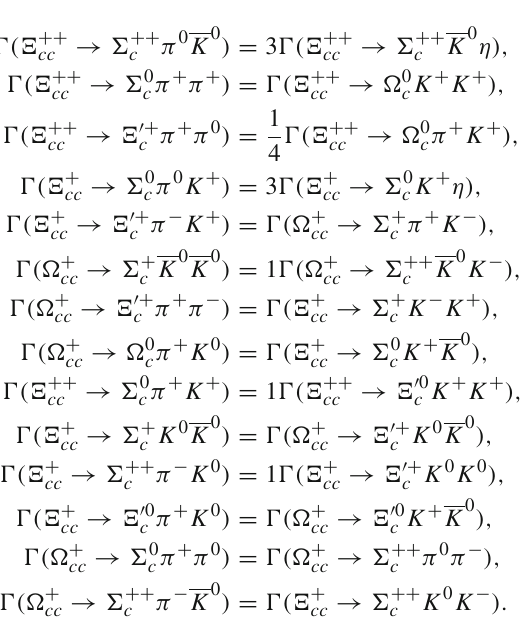
A.3: (cid:2) bb and (cid:5) bb decays into a bottom baryon, J /ψ and a light